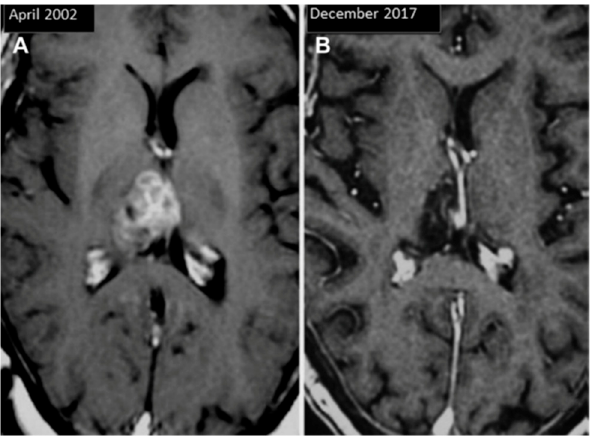
Figure 8. Pineal papillary tumor MRI before ( A ) and after 15 years of treatments ( B ). Reprinted with permission from Fernández-Mateos et al. (2018) [90]. Elsevier—2021 (License Number: with permission from Fern á ndez-Mateos et al. (2018) [90]. Elsevier—2021 (License Number: 5034870401490).